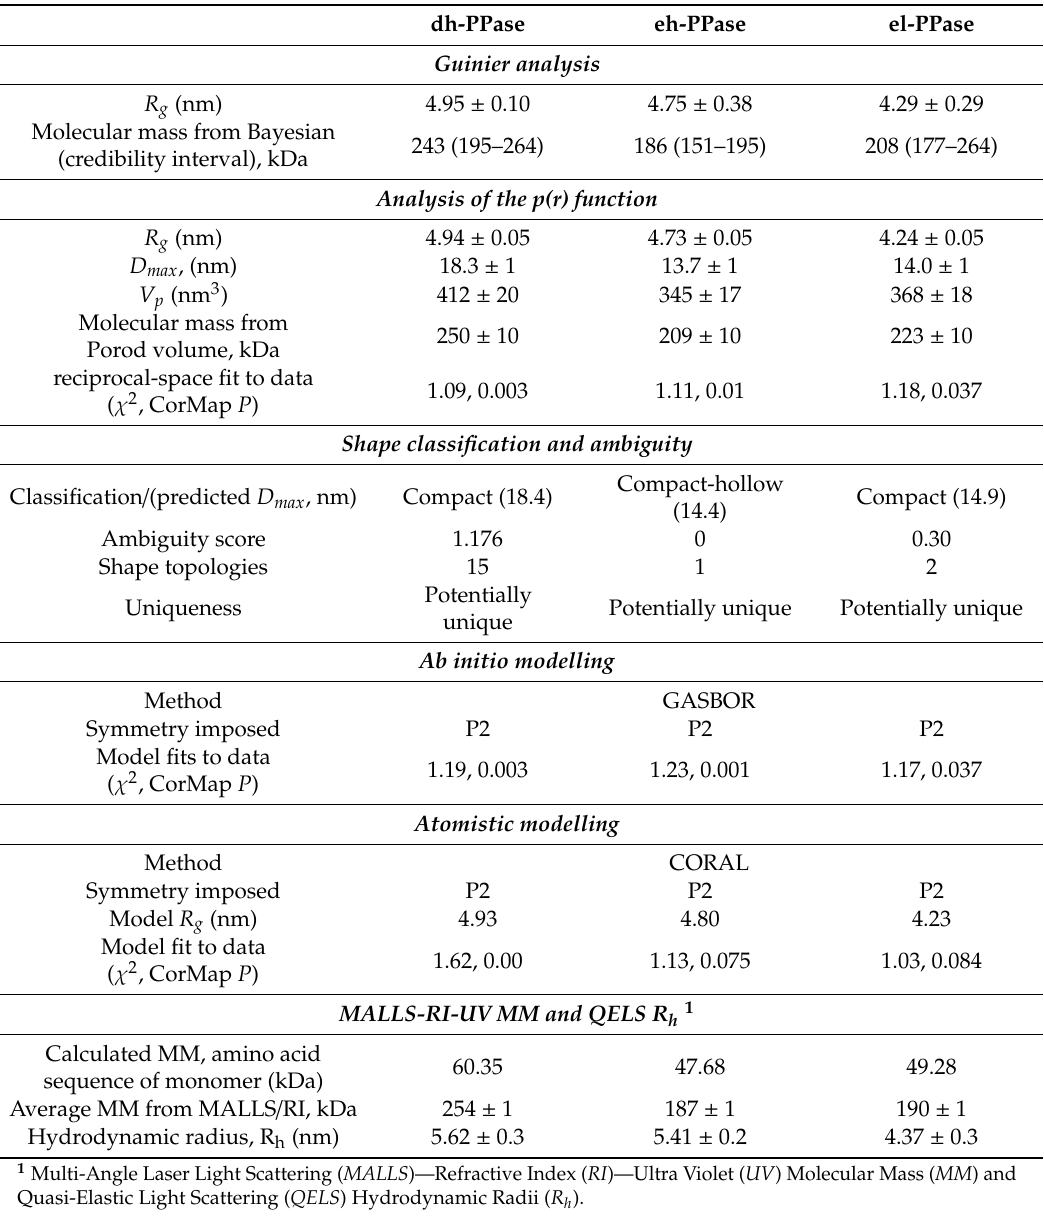
Table 1. Overall structural parameters of CBS-pyrophosphatases